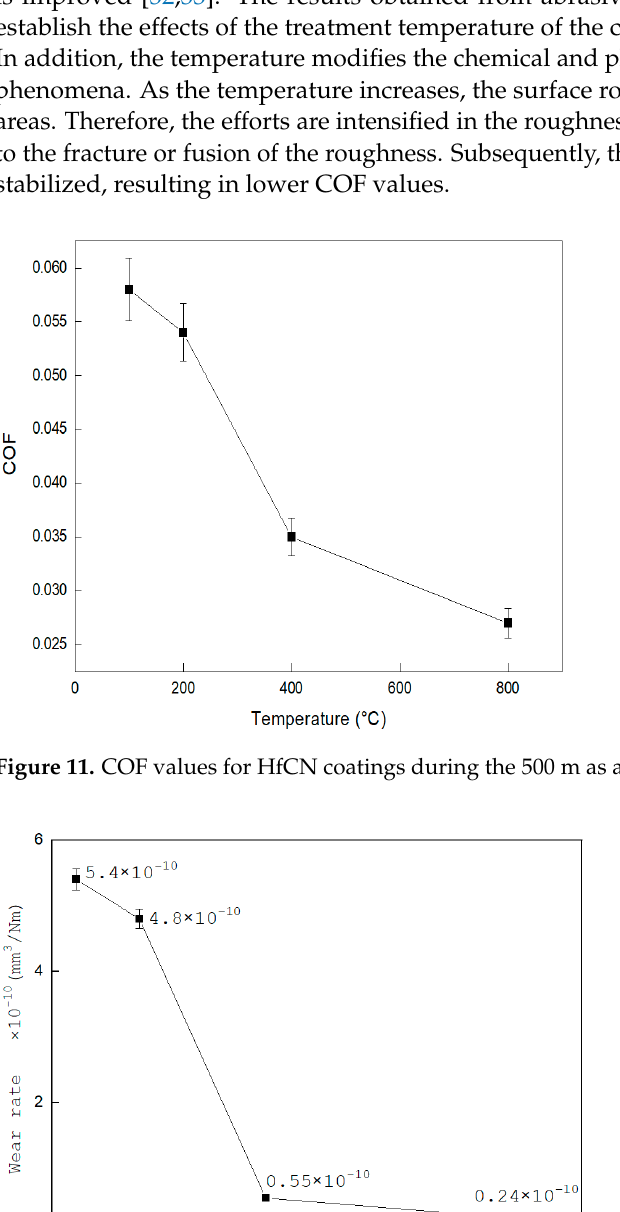
Figure 12. Relationship of wear rates in HfCN coatings as a function of temperature.